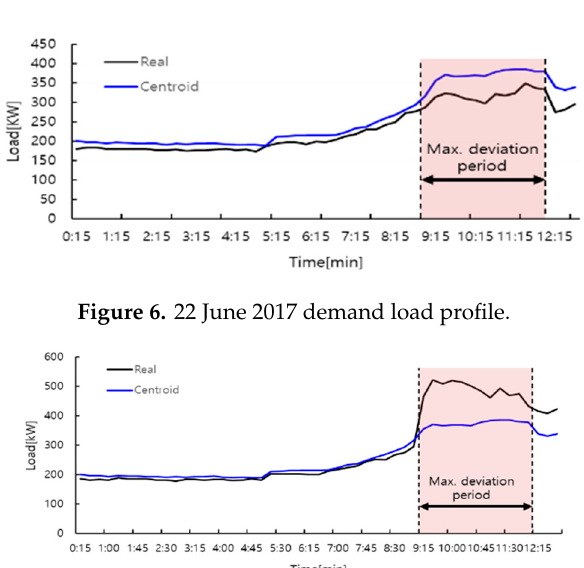
Figure 7. 30 June 2017 demand load profile.